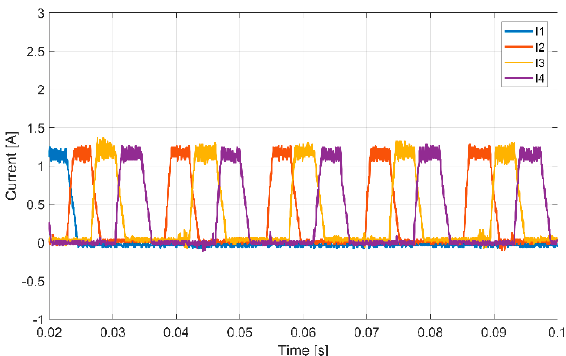
Figure 18. Motor winding currents of the SRM at 600 rpm in normal operation and open-circuit failure of power device S 1 A (experimental result). Appl. Sci. 2020 , 10 , x FOR PEER REVIEW